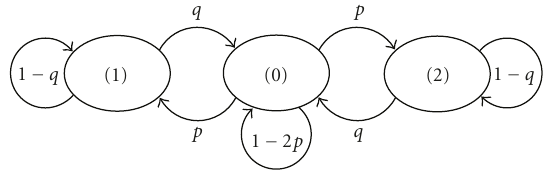
Figure 3: State transition diagram for the Markov chains represent- ing movement in the SIMM model (for both x - and y -directions).